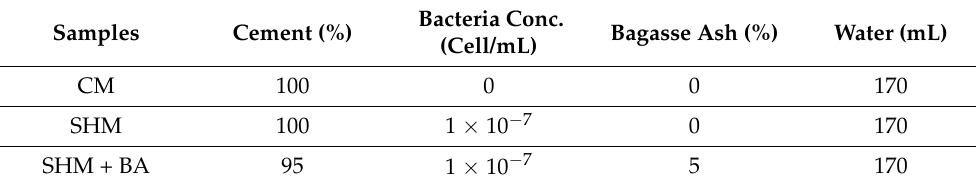
Table 2. Mixing proportion of mortar samples (CM, SHM and SHM + CBA) for flexural strength. (cement + BA: sand = 1:3, calcium lactate 1.5%).